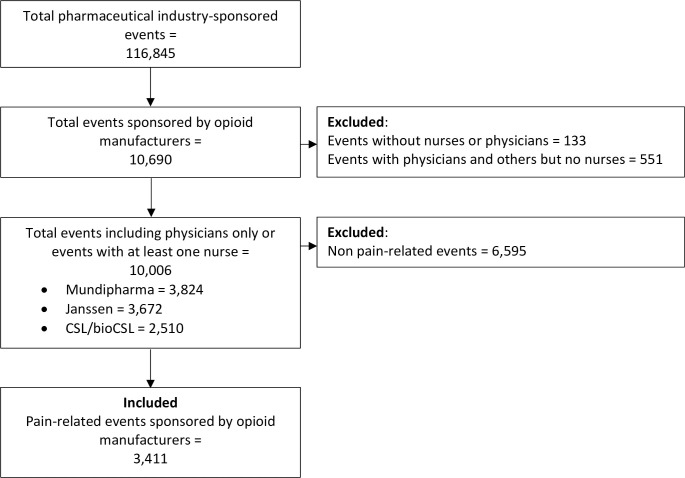
Sampling flow diagram.